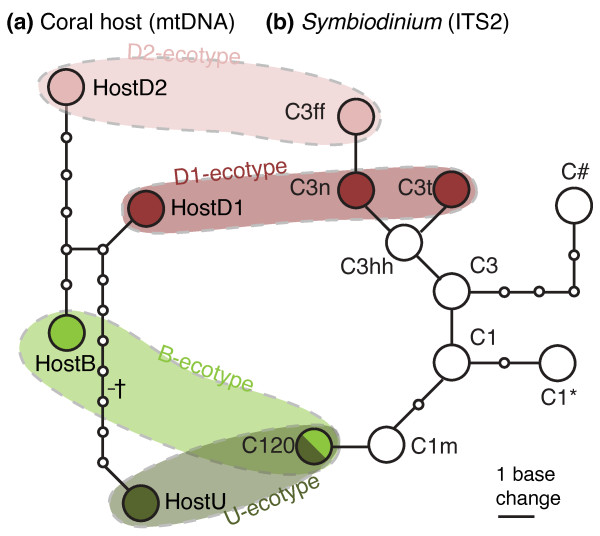
Haplotype networks of Seriatopora hystrix (mtDNA) and the associated Symbiodinium (ITS2). Unrooted haplotype networks of (a) Seriatopora hystrix (mtDNA) and (b) the associated Symbiodinium (ITS2). Colours indicate host and symbiont genotypes that together constitute the four different ecotypes: B-ecotype, U-ecotype, D1-ecotype and D2-ecotype, which are grouped together by the shaded ovals. Dagger (†) indicates a 51bp tandem repeat that was excluded from the analysis.